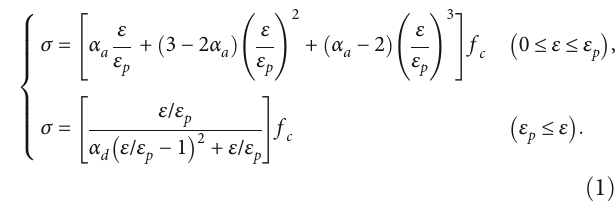
Figure 21: Relationship between peak point strain ε compressive strength f c of PC and PPFRC.